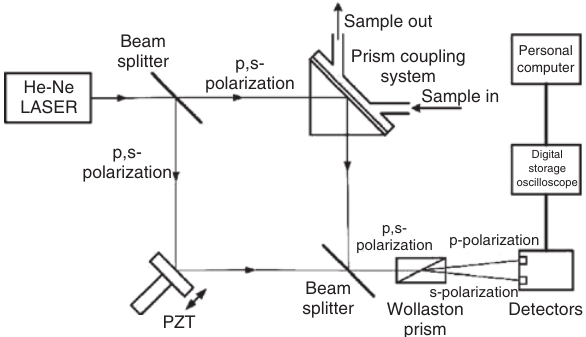
Figure 5: SPR phase sensor based on a Mach-Zehnder interferom- eter. Reprinted with permission from Ref. [43].